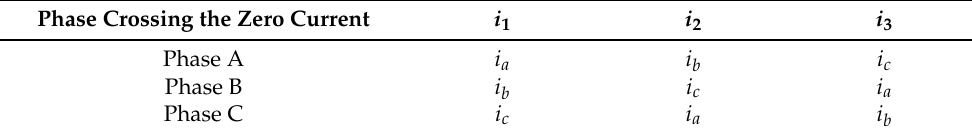
Table 3. Correspondence between the phase currents and Equation (10).